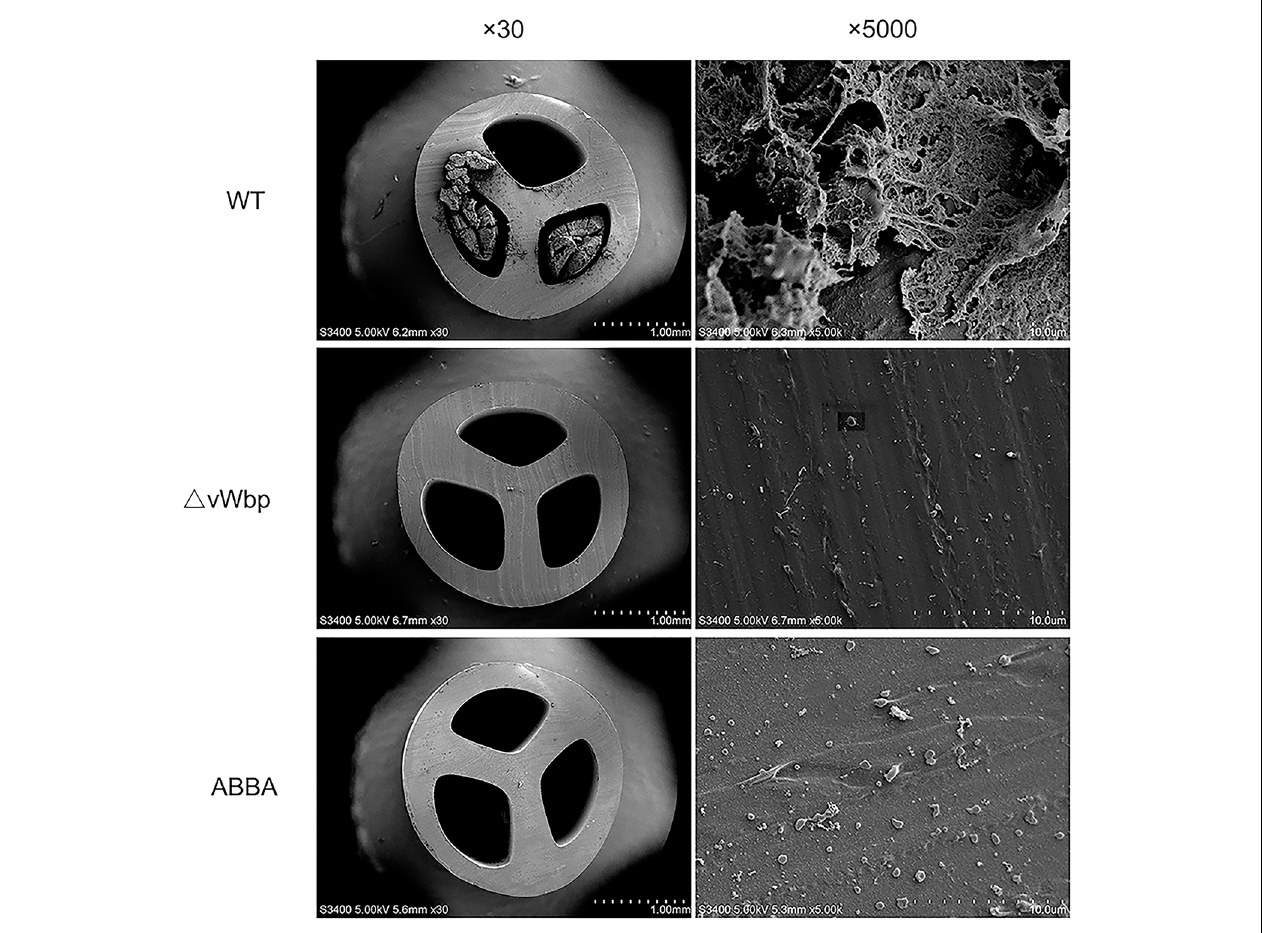
FIGURE 6 | Scanning electron microscopy of catheters inoculated with S. aureus strains harboring or lacking the vWbp gene. Abundant adherent material was seen on the surfaces of catheters incubated in heparin-spiked plasma for 24 h (top row). Both deletion of vWbp (middle row) and inhibition by ABBA at a concentration of 128 µ g/ml (bottom row) reduced the adherent material, leaving cocci on surface of catheter without surrounding matrix.